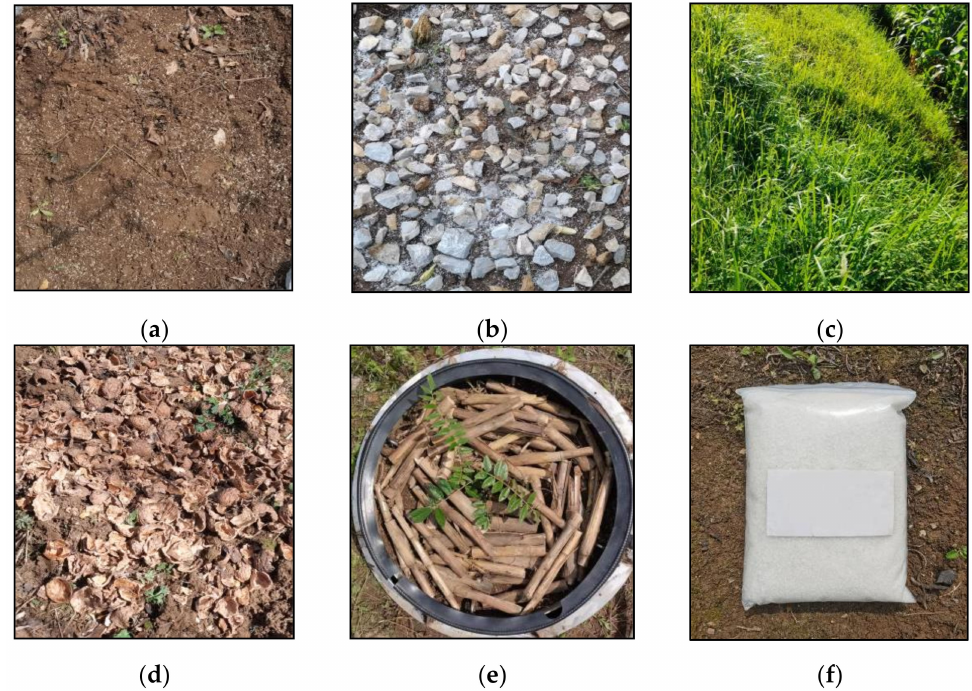
Figure 7. Five soil conservation techniques (mulching) used in karst environments in southern